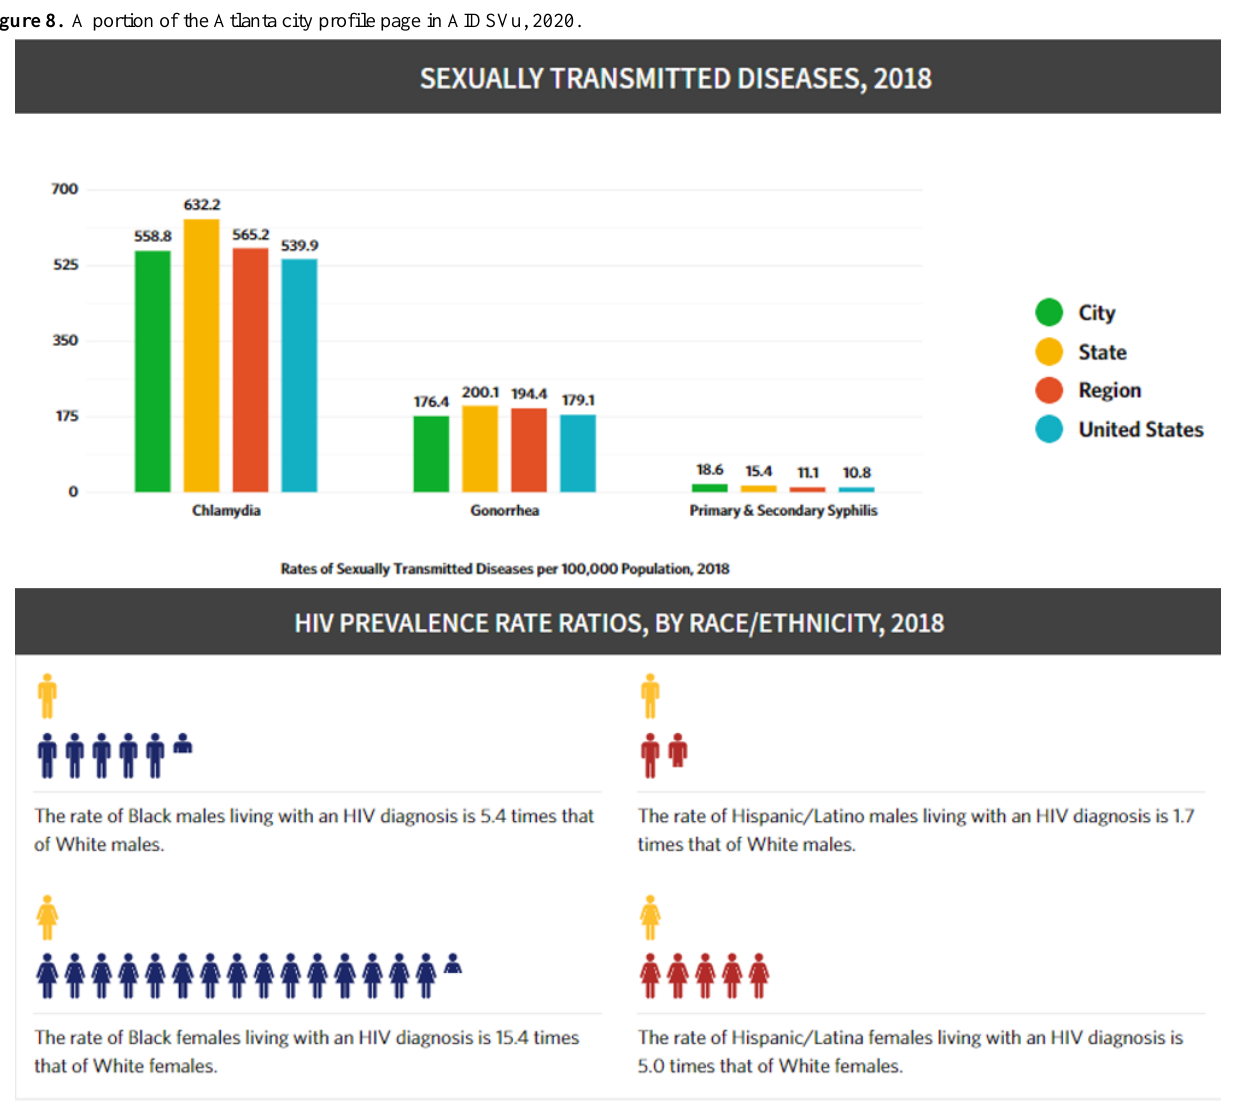
Figure 8. A portion of the Atlanta city profile page in AIDSVu,